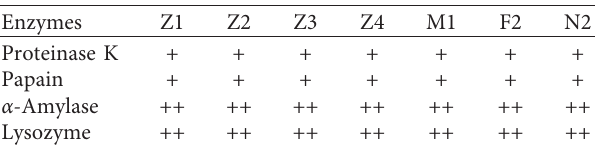
Table 3: Effect of different enzymes on the antibacterial activities of metabolites of the stains.